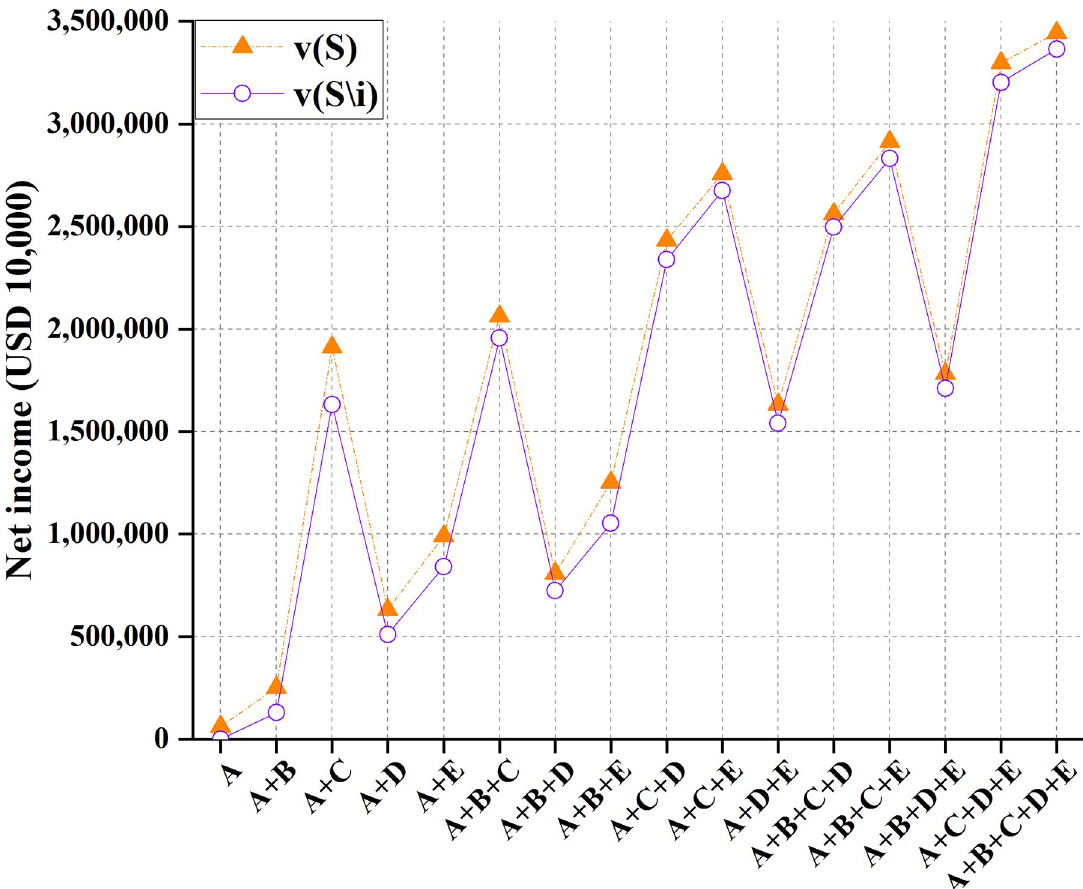
Fig 12. Comparison of profits between China and other countries under 90% water inflow.